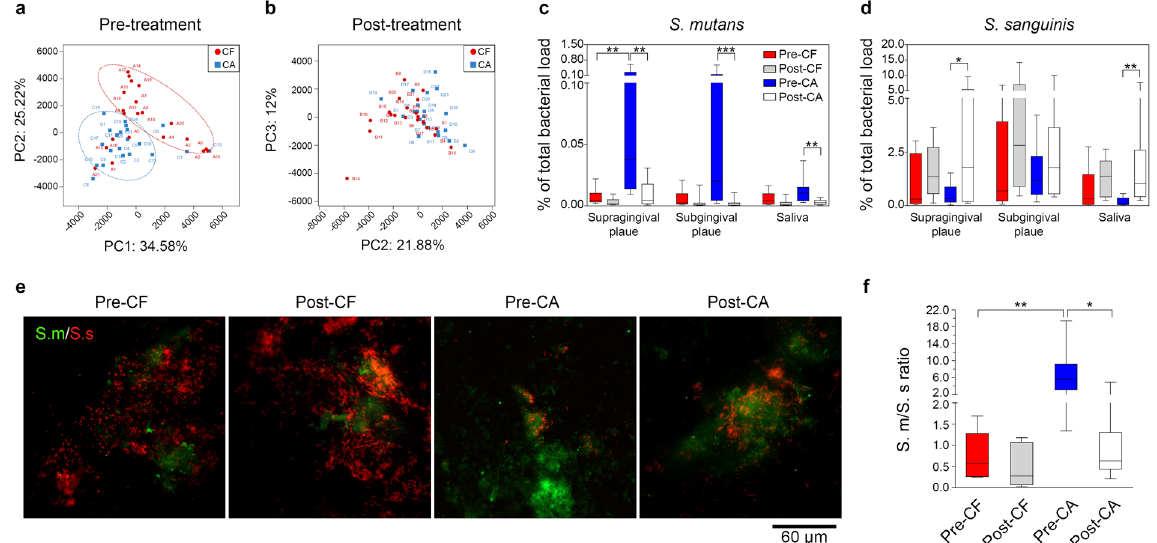
Figure 2. Treatment with arginine-containing dentifrice alters oral microbial composition. Principal Component Analysis (PCA) of saliva microbiome before ( a ) and after ( b ) 2-week arginine-containing toothpaste treatment (n = 21 in each group). Abundance of S. mutans (S. m) ( c ) and S. sanguinis (S. s) ( d ) in all types of samples before and after the treatment. Bacterial counts were determined by species-specific qPCR, and normalized with the total bacterial load. Data are presented as standard box plot, with the boxes presenting the first and third quartiles and the whiskers representing the 5th and 95th percentiles. (n = 15; Kruskal-Wallis test followed by Dunn’s multiple comparison test; * p < 0.05, ** p < 0.01, *** p < 0.001). ( e ) Representative images of in situ plaques labeled by S. m- and S. s-specific fluorescent in situ hybridization (FISH) probe. ( f ) Quantitative analysis of S. m/S. s ratio in the in situ plaques, bacterial loads were measured based on integral optical density (IOD). Data are presented as standard box plot. (n = 3; Kruskal-Wallis test followed by Dunn’s multiple comparison test; ** p < 0.05, ** p < 0.01). Pre-CF and Post-CF = caries-free group before and after arginine-containing toothpaste treatment respectively; Pre-CA and Post-CA = caries-active group before and after arginine-containing toothpaste treatment